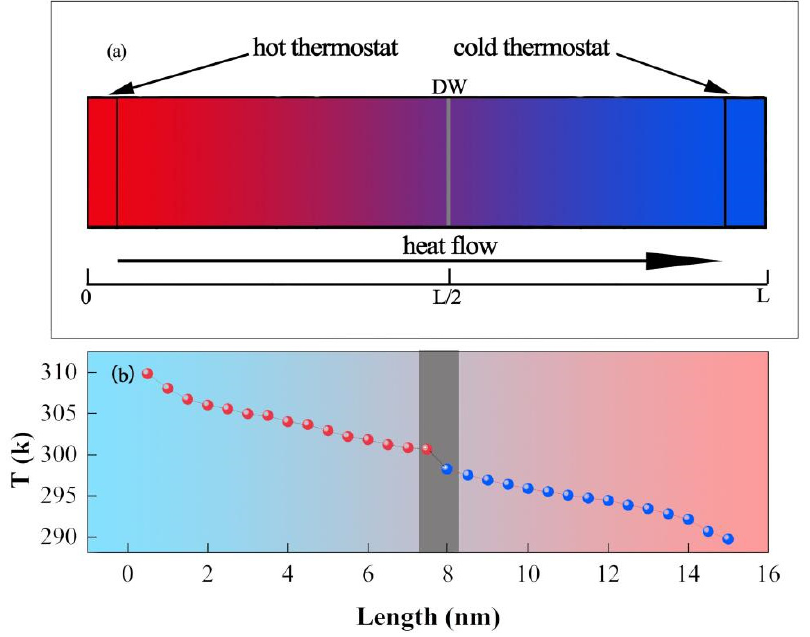
Figure 6. ( a ) Schematic view of KTN supercell with single 90 ◦ DW for TBR calculation. ( b ) Temperature gradient along the z -axis for single 90 ◦ DW of KTN.